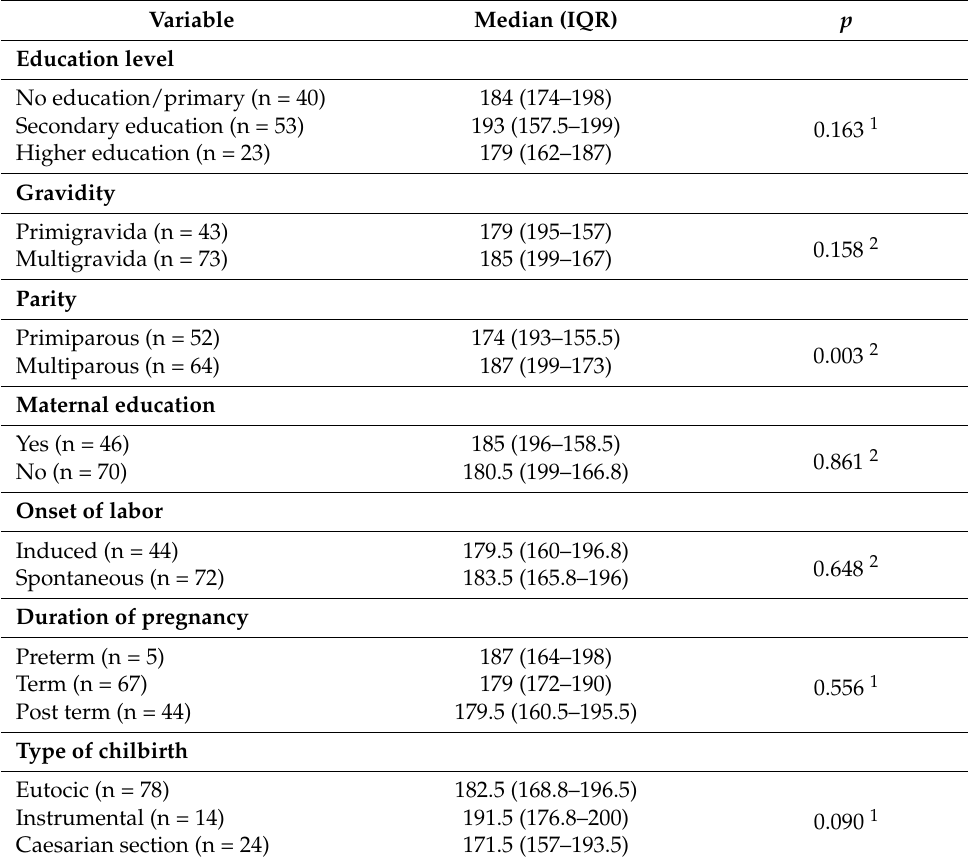
Table 3. Analysis of factors associated with COMFORTS scale scores.